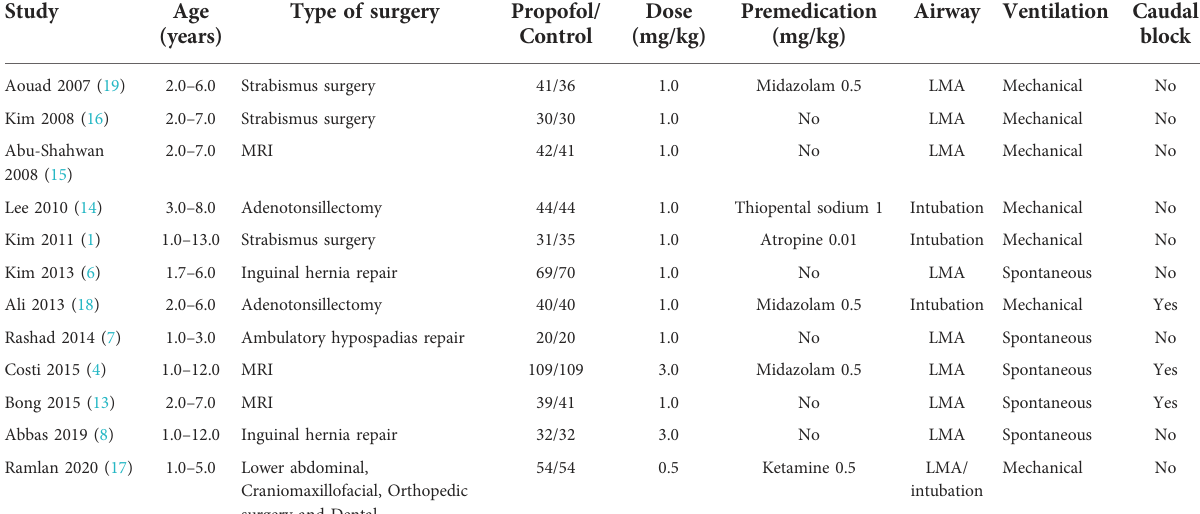
TABLE 1 Basic characteristics of included